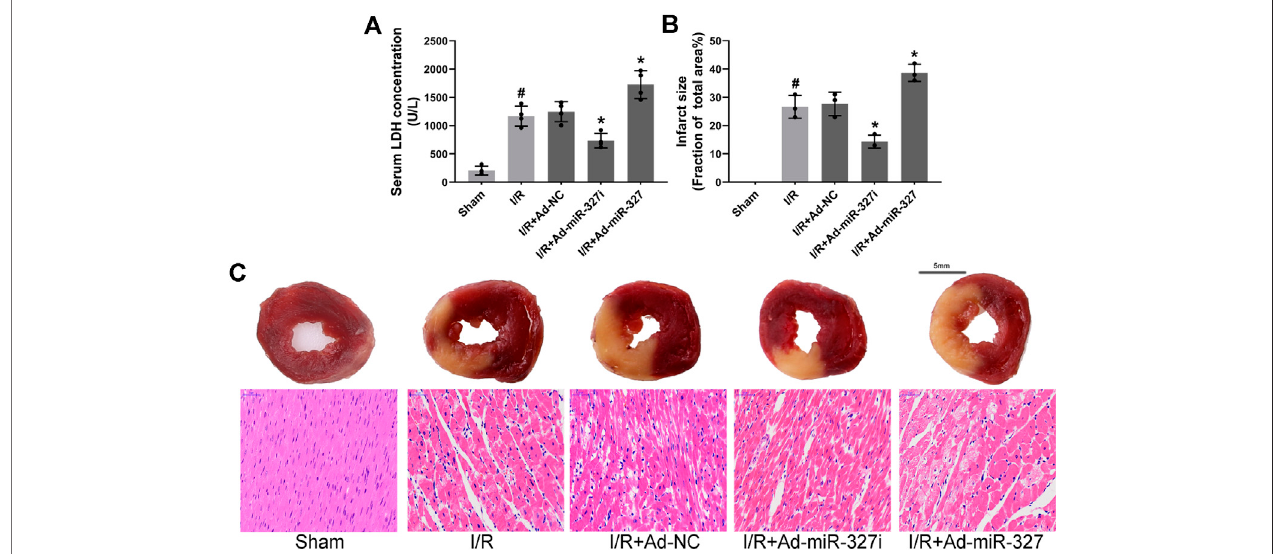
FIGURE9| EffectsofmiR-327onMI/RIinrats.SerumLDHconcentration( n (cid:2) 4)ineachgroup (A) .AssessmentofmyocardialinfarctionbyTTCstaining( n (cid:2) 3)and HE staining.ForTTCstaining,thered arearepresentsnon-infarcted tissue,whilethe whitearearepresents infarcted tissue (C) ,and myocardial infarct sizeexpressed as (whitearea)/(whitearea+redarea)( B) .RepresentativeimagesofHEstainingineachgroup (C) .Dataareexpressedasthemean ± SD;# p < 0.05versustheShamgroup; * p < 0.05 versus the Ad-NC group.